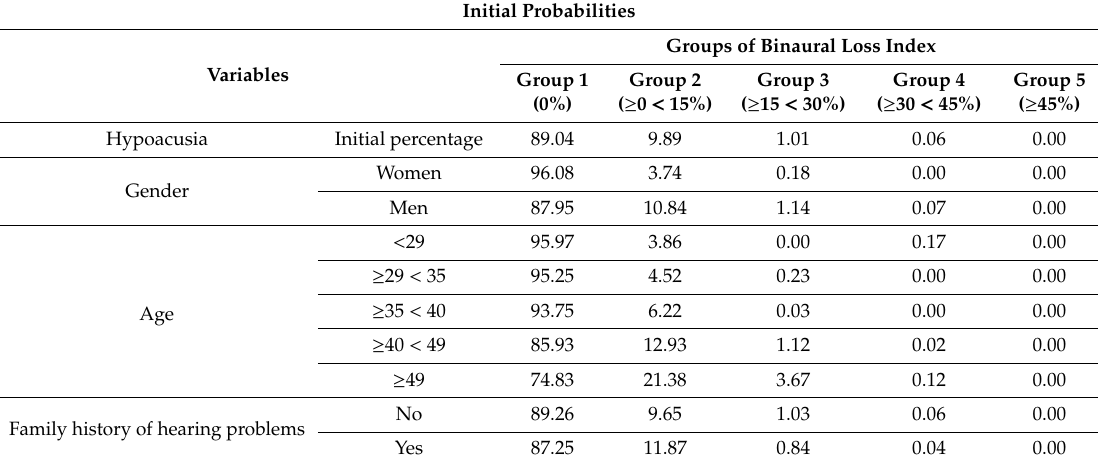
Table 4. Initial probabilities of the variables vs. Percentage of Binaural Loss Index. Source: Compiled by authors.